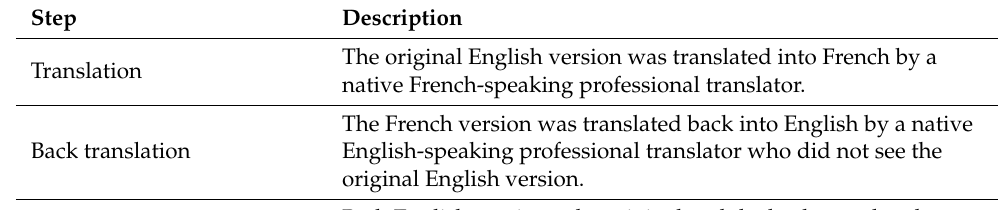
Table 1. Transcultural adaptation process steps of the